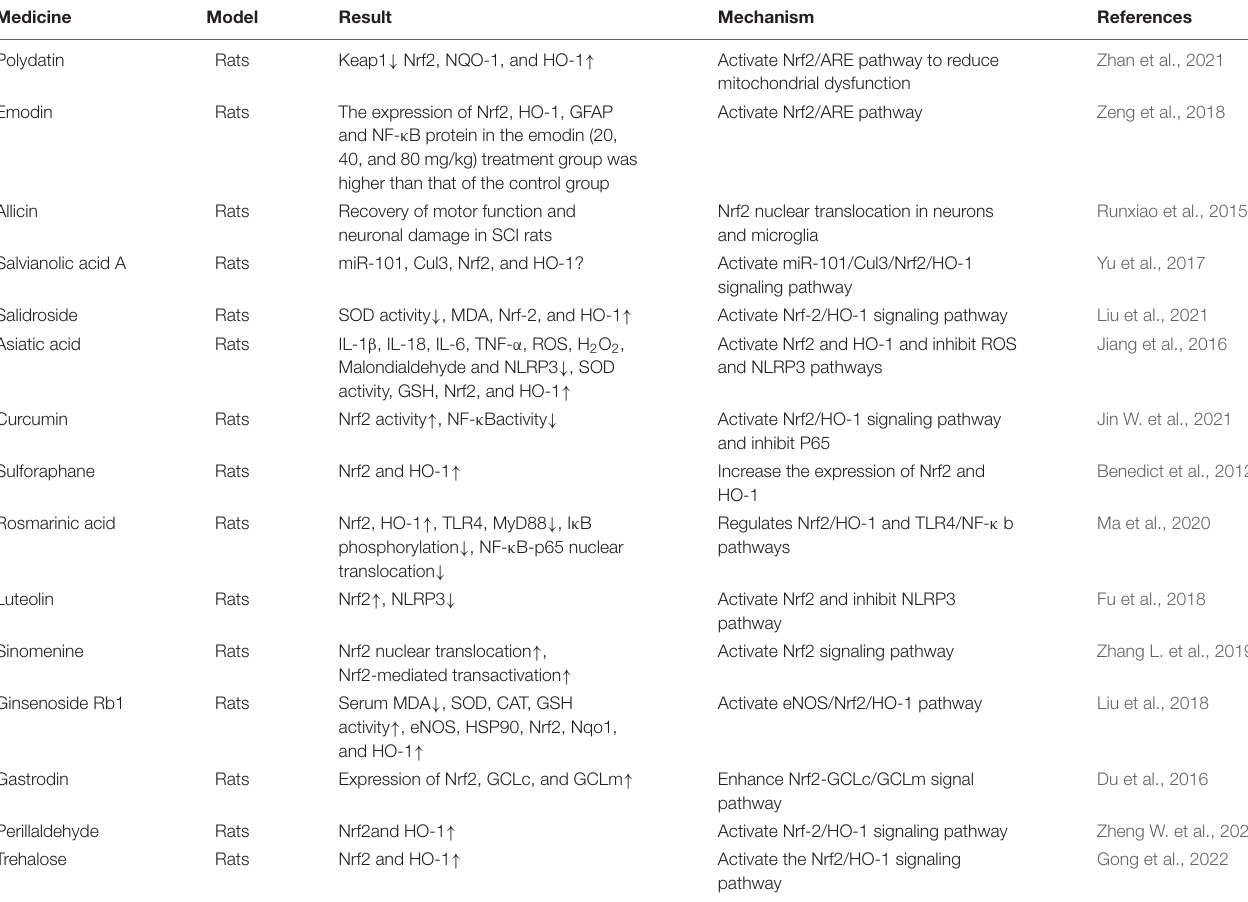
TABLE 1 | The therapeutic effects of Chinese herbal medicine on spinal cord